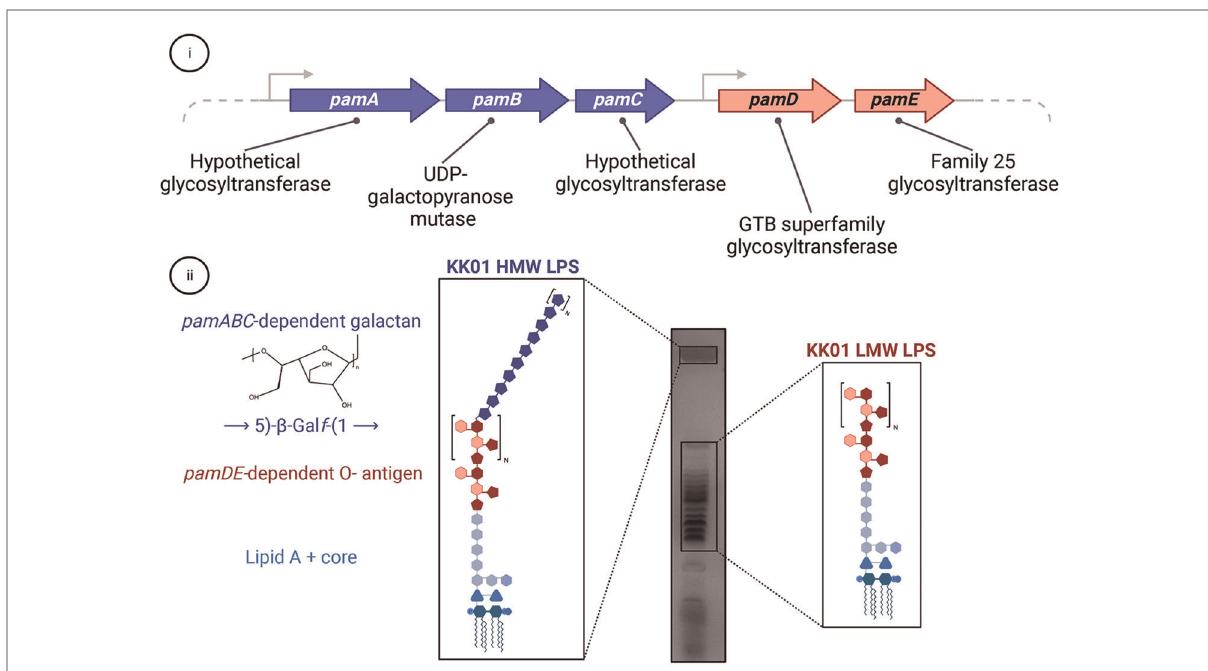
FIGURE 4 The relationship between the galactan exopolysaccharide and LPS in K. kingae . (i) The pamABCDE locus is essential for presentation of the galactan exopolysaccharide on the bacterial surface and contains genes encoding four predicted glycosyltransferases ( pamA, pamC, pamD, and pamE ) and one predicted UDP-galactopyranose mutase ( pamB ). (ii) The pamABC genes are necessary for synthesis of the galactan homopolymer with the structure of → 5)- β -Gal f -(1 → , which is linked to the atypical O-antigen. The pamDE genes are required for synthesis of the atypical O-antigen. In wild type K. kingae strain KK01, the LPS migrates as two distinct modal clusters: a high molecular weight (HMW) band that contains LPS decorated with both the atypical O-antigen and galactan and a low molecular weight ladder cluster that contains LPS decorated with only the atypical